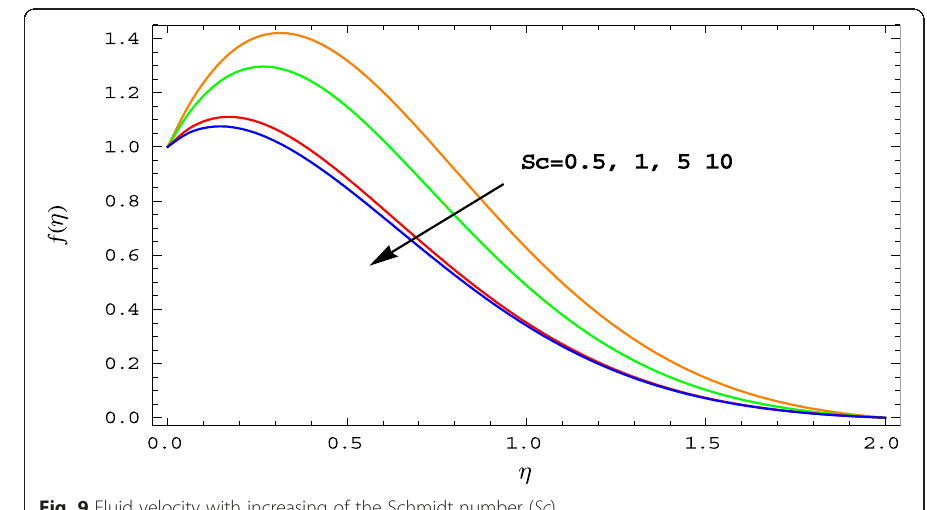
Fig. 9 Fluid velocity with increasing of the Schmidt number ( Sc